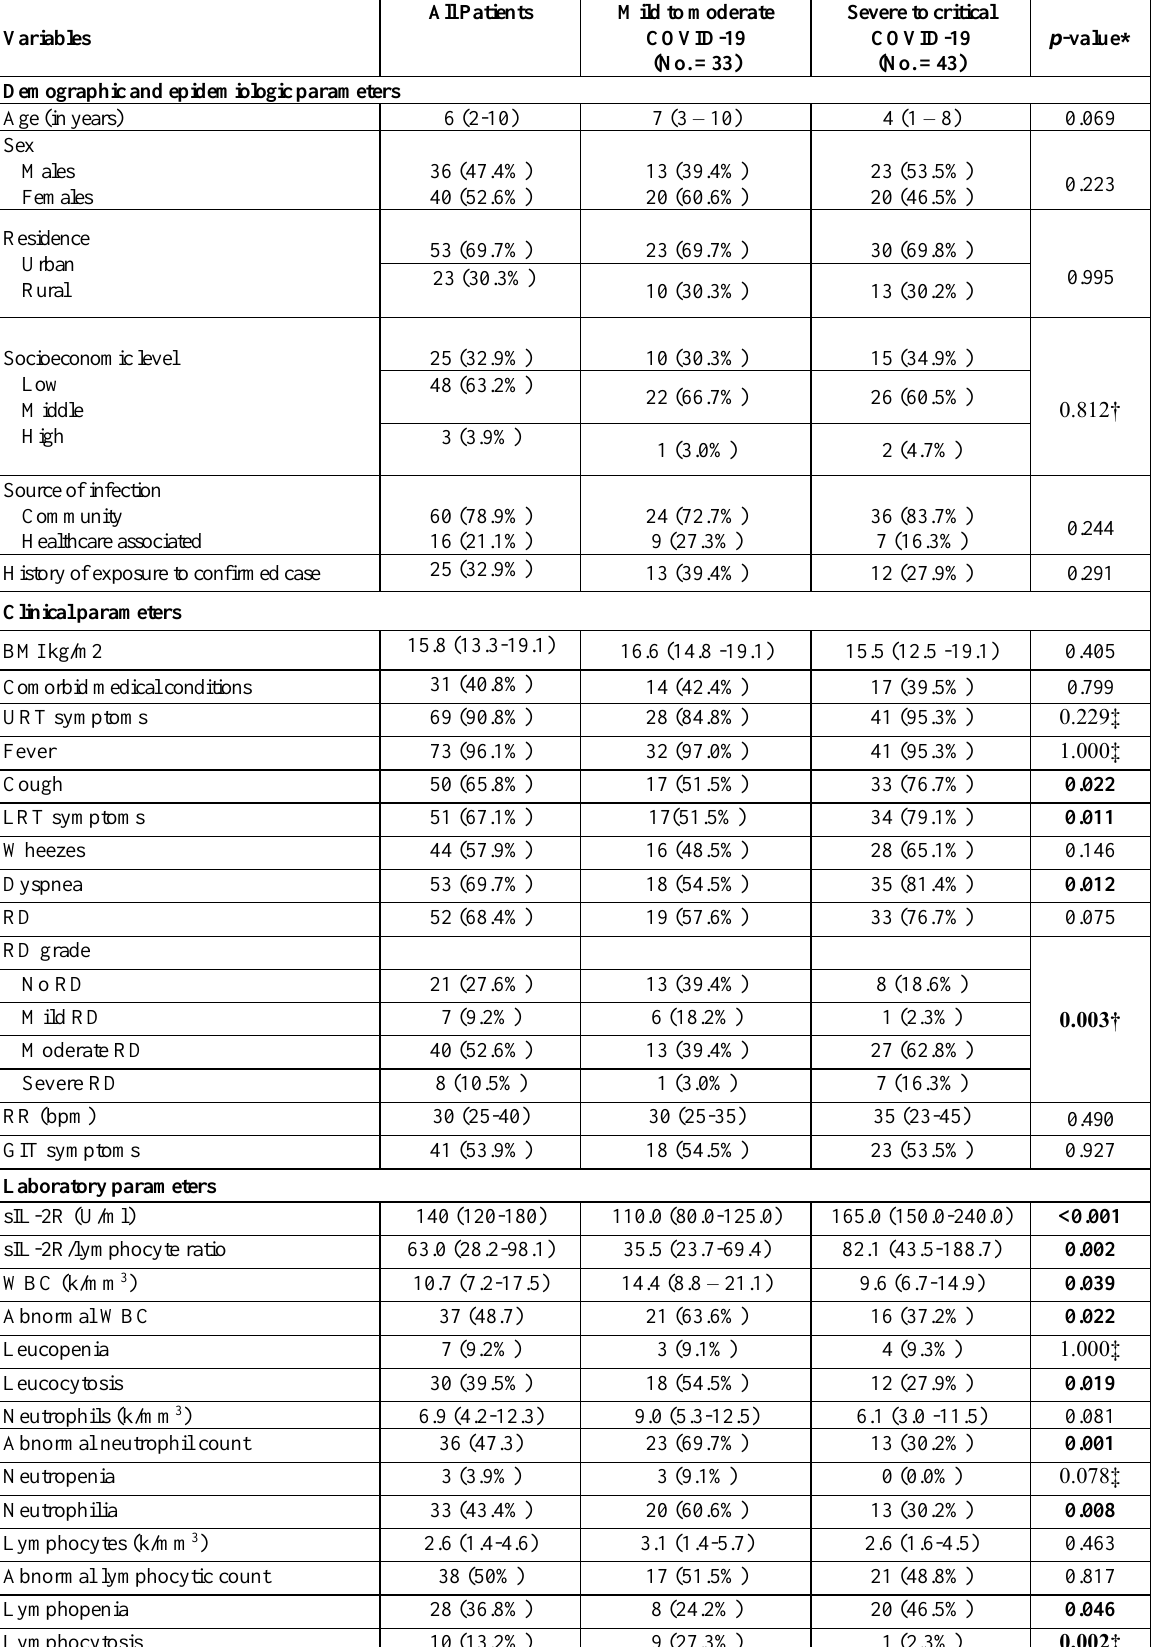
Table 1 . Demographic, laboratory and general clinical characteristics of the study population